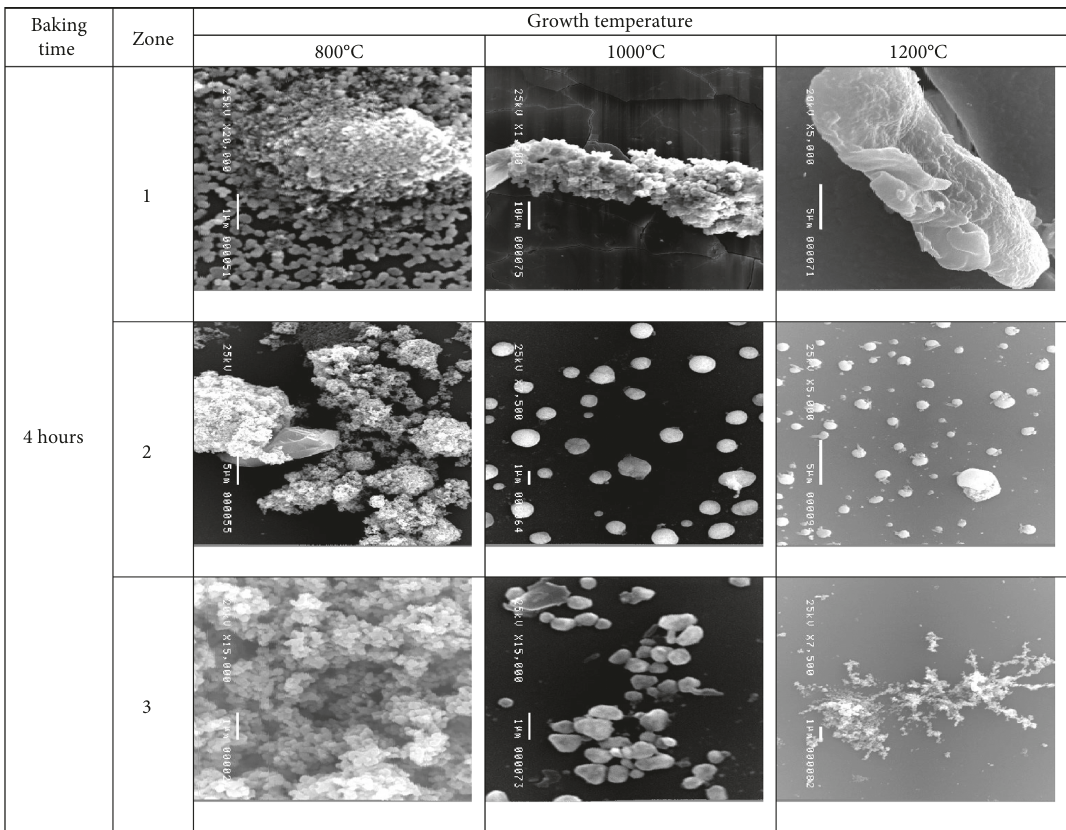
Figure 5: SEM image after 4hours of baking